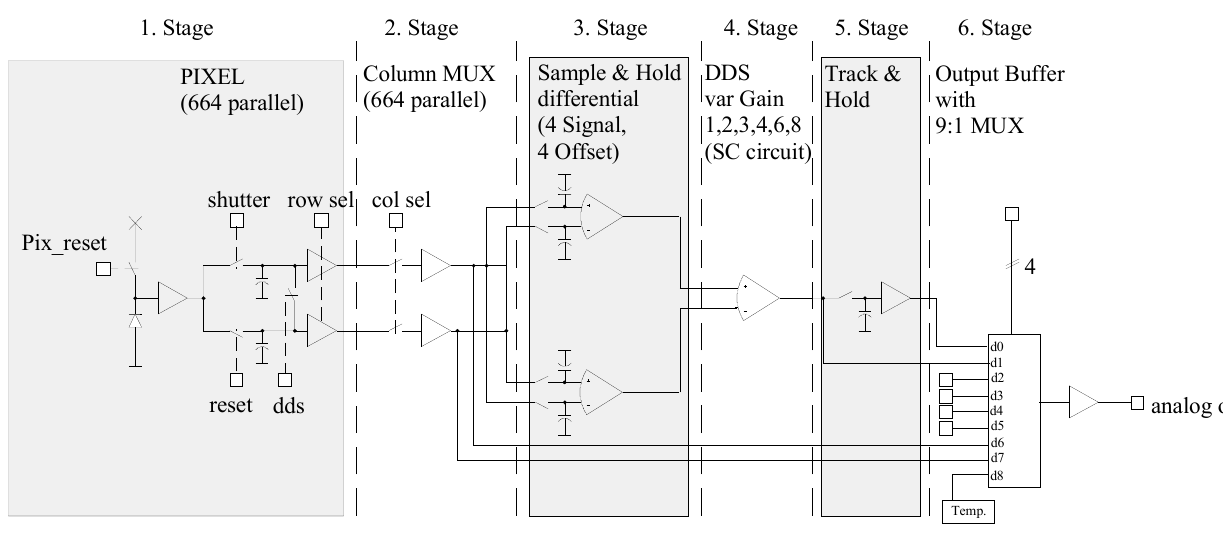
Figure 4. Schematic Architecture of the APS analog signal